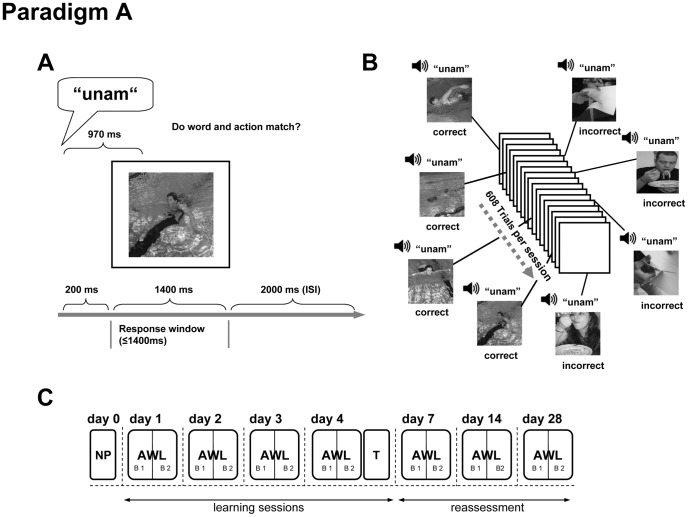
Design of Paradigm A.A Paradigm A single trial layout. Each trial is composed of one pseudoword in connection with a picture. 200 ms after onset of sound, the picture is shown and remains on the screen for 1400 ms representing the response window. After each stimulus pair is a pause of 2000 ms. B Paradigm A trial sequence during a learning session. Pseudowords are coupled with different pictures of actions. Correct couplings appear more often than incorrect couplings (for details see text). C Timeline of Paradigm A Four learning sessions are followed by the translation test and three reassessment sessions. NP: neuropsychological evaluation AWL: action word learning T: translation B: BlockISI: Interstimulus Interval.